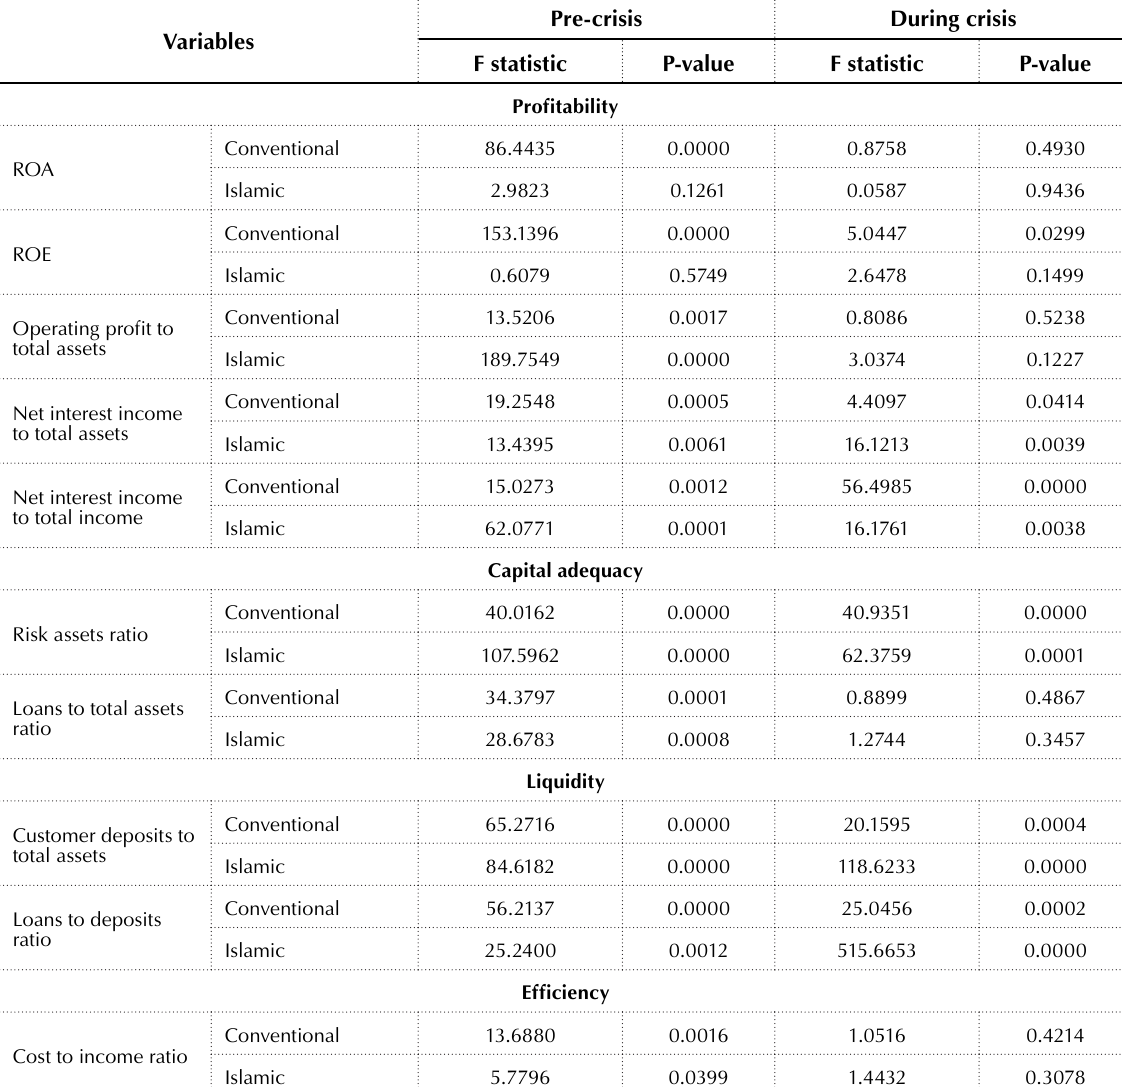
Table 5. Single factor ANOVA on conventional & Islamic banks